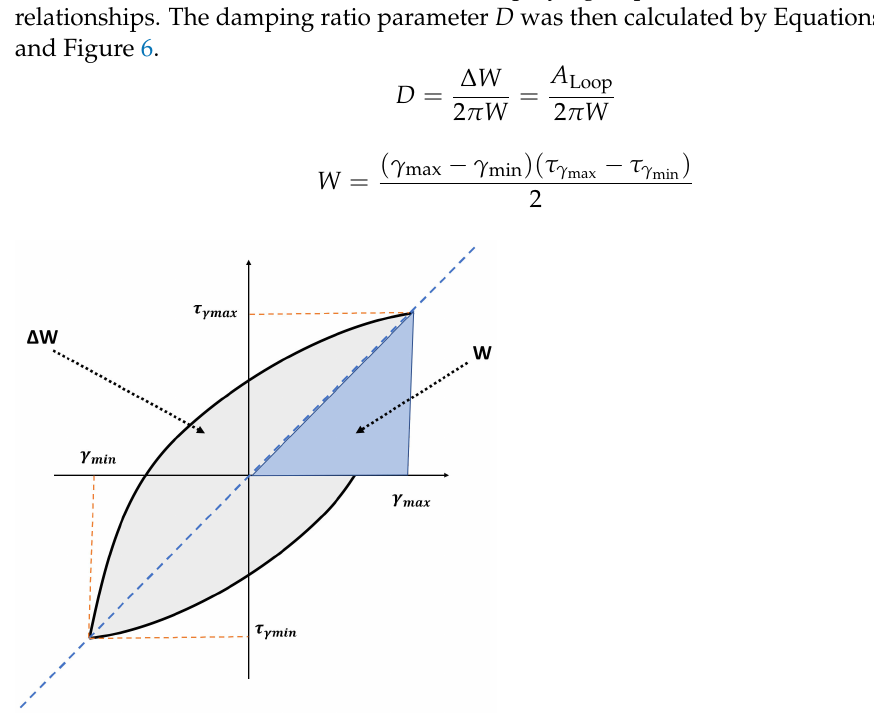
Figure 6. Hysteresis loop in cyclic tests.